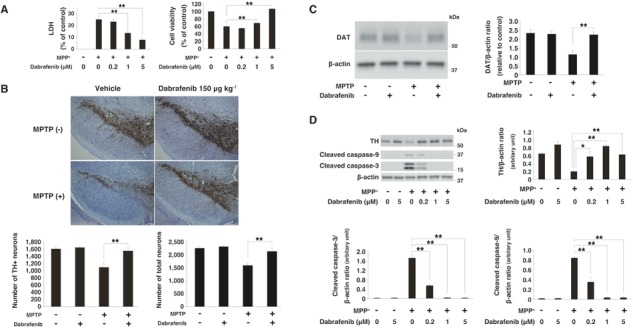
Neuroprotective effects of dabrafenib both in vitro and in vivo(A) LDH/cell viability assay under the condition of MPP+. Dabrafenib inhibited LDH release and the loss of cell viability at 24 h after MPP+ (3 mM) treatment in a concentration-dependent manner. Data represent the mean ± s.e.m. **, P-value < 0.01 compared with MPP+ alone (one-way ANOVA with the Tukey post-hoc test; n = 4 per group). (B) Immunohistochemistry staining of TH. Dabrafenib (150 μg kg−1) prevented the MPTP-induced loss of TH-positive and total neurons in the substantia nigra at 3 weeks after MPTP injection. Scale bar represents 200 μm. Data represent the mean ± s.e.m. **, P-value < 0.01 compared with vehicle + MPTP group (one-way ANOVA with the Tukey post-hoc test; n = 5–9 per group). (C) Immunoblotting showed that dabrafenib rescued the loss of DAT in the substantia nigra of mice 3 weeks after MPTP injection. Data represent the mean ± s.e.m. **, P-value < 0.01 compared with vehicle + MPTP group (one-way ANOVA with the Tukey post-hoc test; n = 3–4 per group). (D) Western blot analysis showed that dabrafenib reduced the levels of cleaved caspase-3 and 9 at 48 h after MPP+ (3 mM) treatment. Data are represented as the mean ± s.e.m. **, P-value < 0.01 compared with MPP+ alone (one-way ANOVA with the Tukey post-hoc test; n = 3 per group).